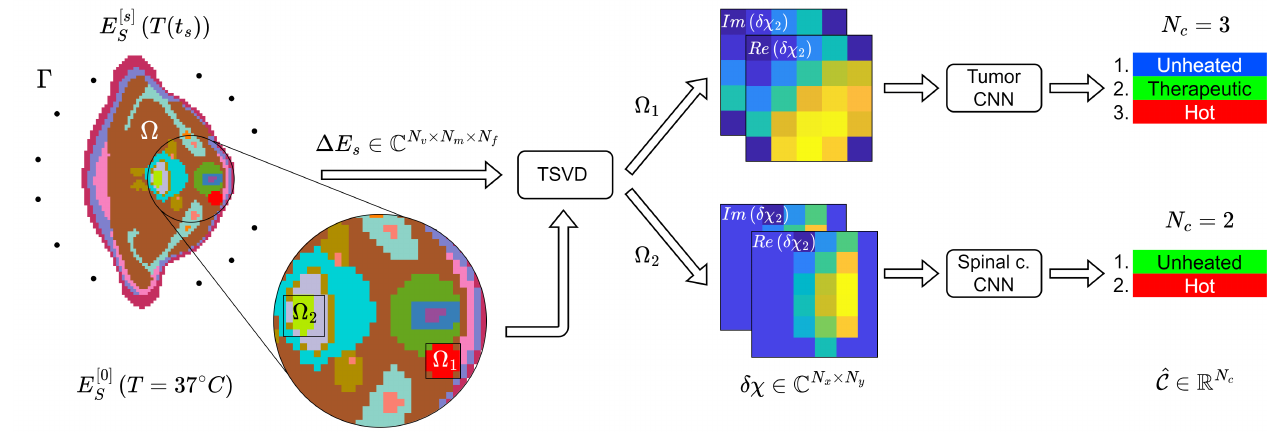
Figure 4. DL-MWI framework for monitoring temperature in neck tumor HT. Two separate CNNs simultaneously check the temperature status of the treated tumor and the spinal cord. In the figure, Ω Ω 2 is the spinal cord to be 1 denotes the tumor region and